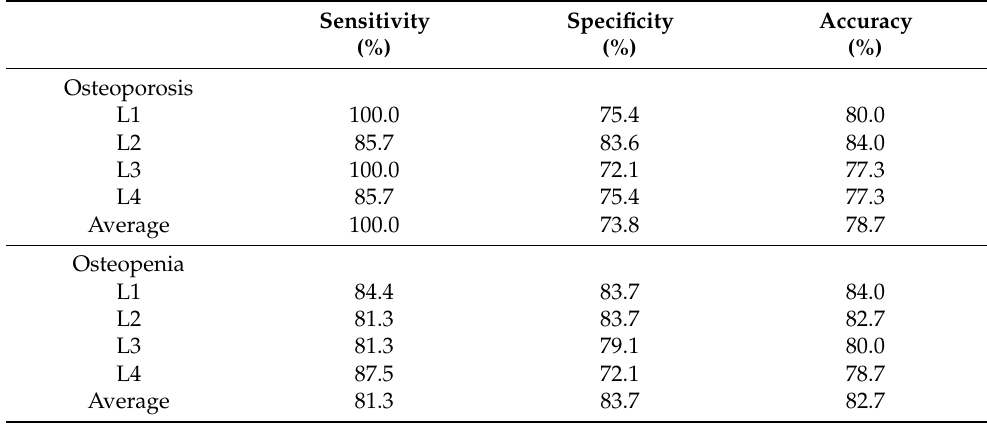
Table 3. Sensitivity, specificity, and accuracy of the diagnostic thresholds for osteoporosis and osteopenia calculated for the patients in the test